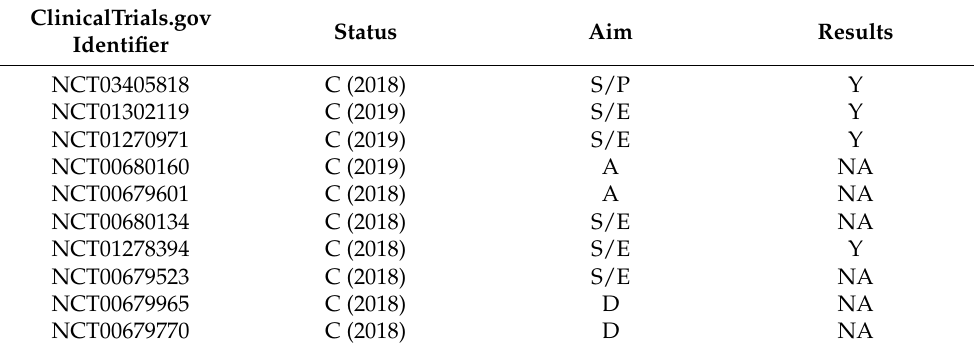
Table 2. Clinical trials involving tavaborole as antifungal agent (from https://clinicaltrials.gov/, accessed on 27 April 2021).